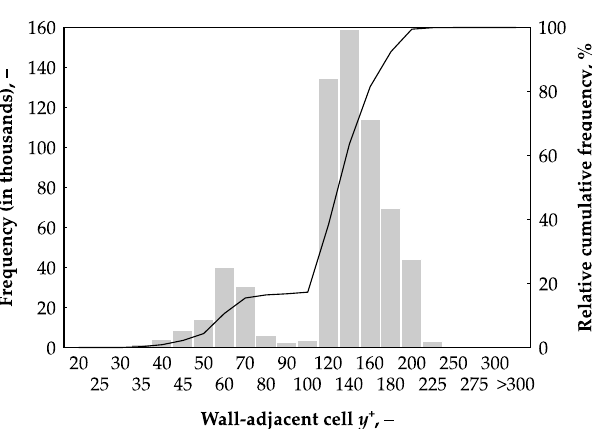
Figure 10. Histogram of y + values of wall-adjacent cells in the model from Table 5. There were 275 cells with y + ≤ 30 (all of these but 12 were between 25 and 30, ca. 0.04% of the total number of wall-adjacent cells) and no cells with y + > 300.